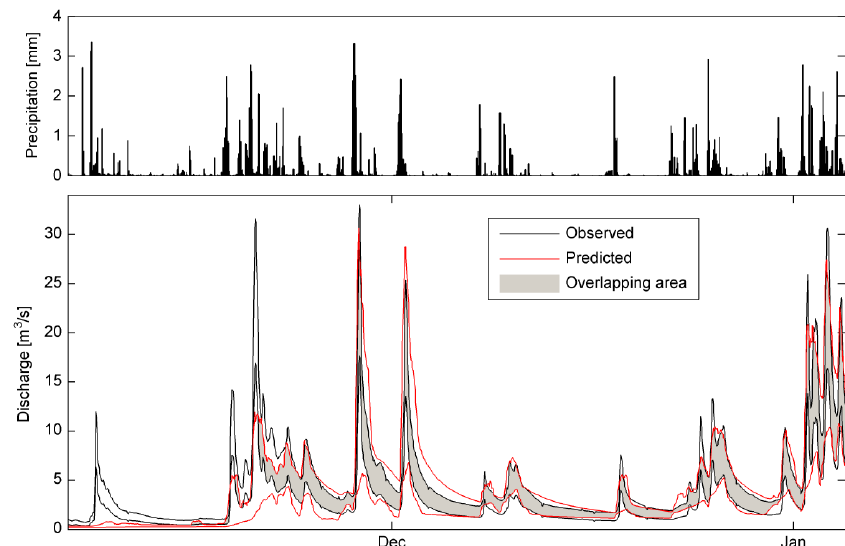
Fig. 17. Uncertainty limits for observed discharge in 1997–1998 and predicted discharge (5% and 95% percentiles of the predicted discharge of all behavioural parameter-value sets calibrated in 1995–1996 using the R FDC − V performance measure) for the same period for Dynamic TOPMODEL in the Brue catchment. The overlapping area between the two uncertain intervals is plotted in grey. In the beginning of November there was a period where the model could not reproduce the observations.